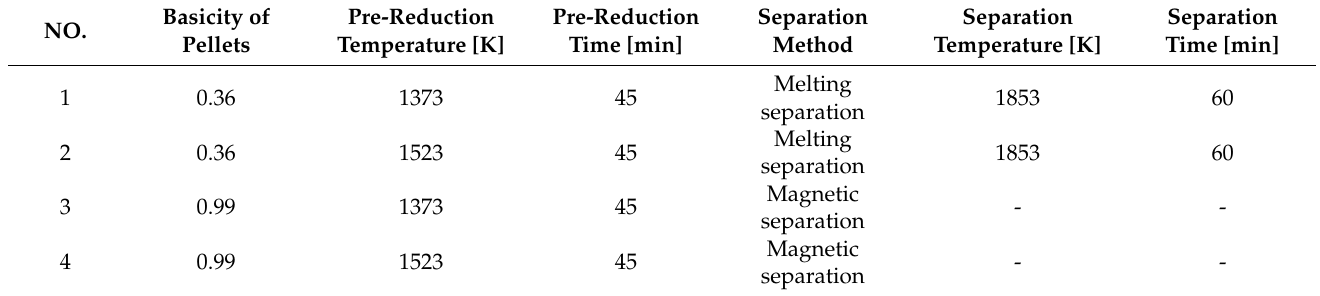
Table 3. Experimental scheme and operating